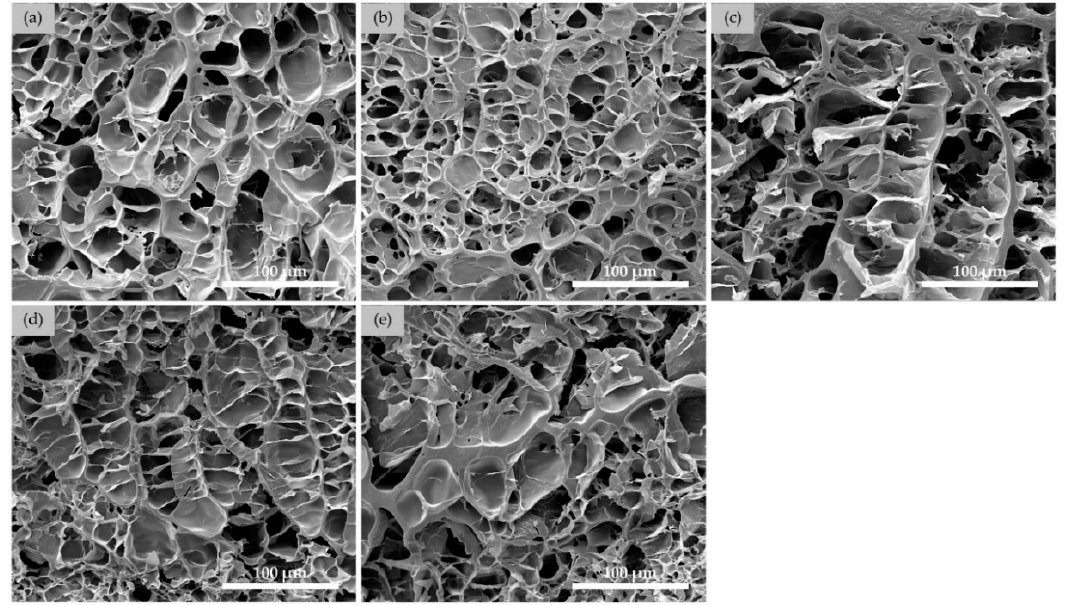
Figure 3. SEM micrographs of cross-sections of SN starch hydrogels after 24 h of crosslinking time, at various GA contents (1000× of magnification): ( a ) SN10, ( b ) SN20, ( c ) SN30, ( d ) SN40, and ( e ) SN50. In Figure 2, SEM images of SN30 starch hydrogels formed at various crosslinking times revealed well-interconnected networks in all the hydrogel specimens. As the crosslinking time was extended from 2 to 24 h, the pore wall thickness and pore size of SN hydrogels increased. Quantitative analysis of the SEM micrographs was carried out and the results were summarized and showed in Table